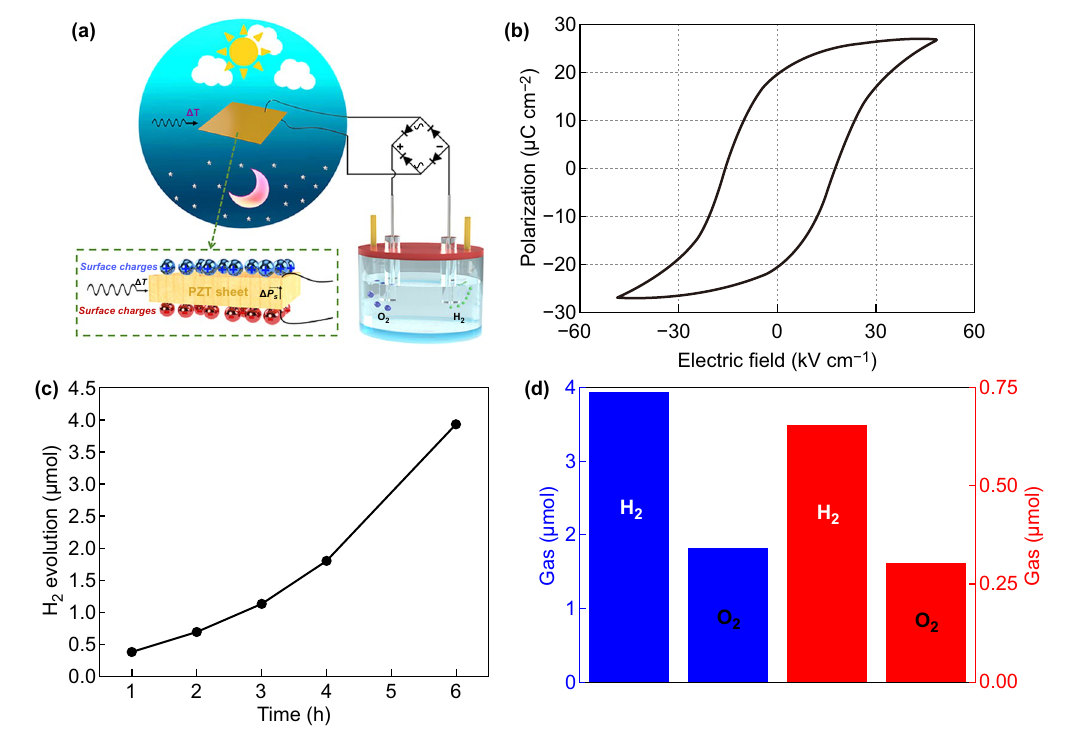
Fig. 15 a Schematic of pyroelectric as an external source for water splitting, b polarization–electric field loop of PZT sheet and schematic of the surface pyroelectric charges, c H 2 evolution from external pyroelectric water splitting with working time from 1 to 6 h, d the amount and evolu- tion rate of H 2 and O 2 after 6 h detected from the gas chromatography. Reproduced with permission from Ref. [185]. Copyright 2020 Elsevier